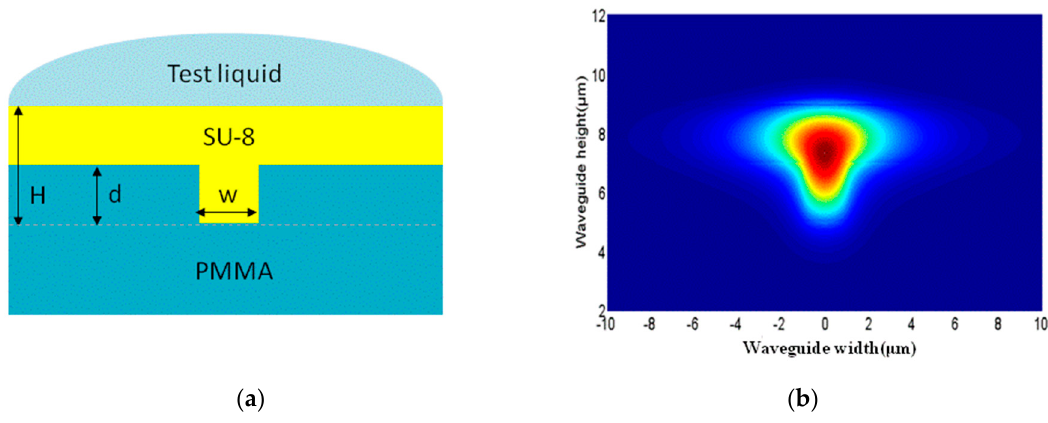
Figure 6. ( a ) Cross-section and ( b ) optical field distribution of inverted ridge waveguide.